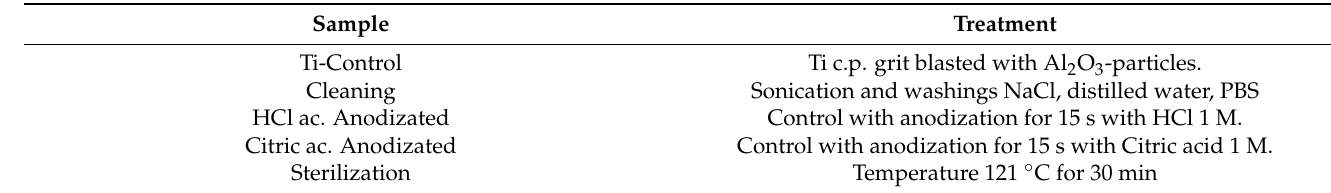
Table 1. Summary of the titanium sample